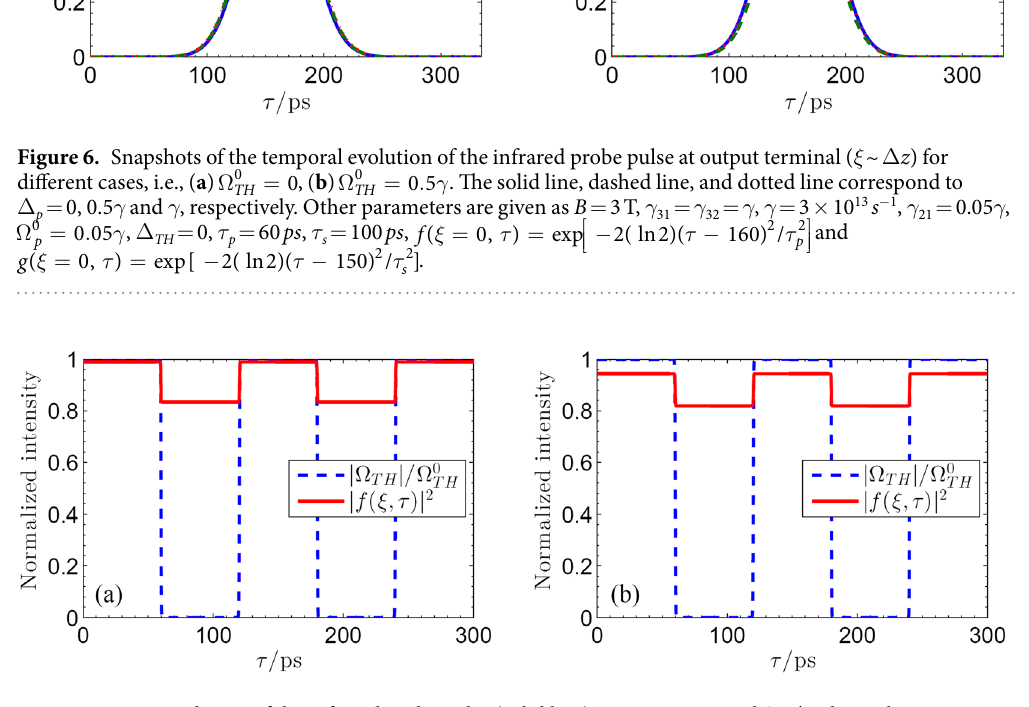
Figure 7. Time evolution of the infrared probe pulse (solid line) at output terminal ξ ~ Δ z driven by a THz switch pulse with wave